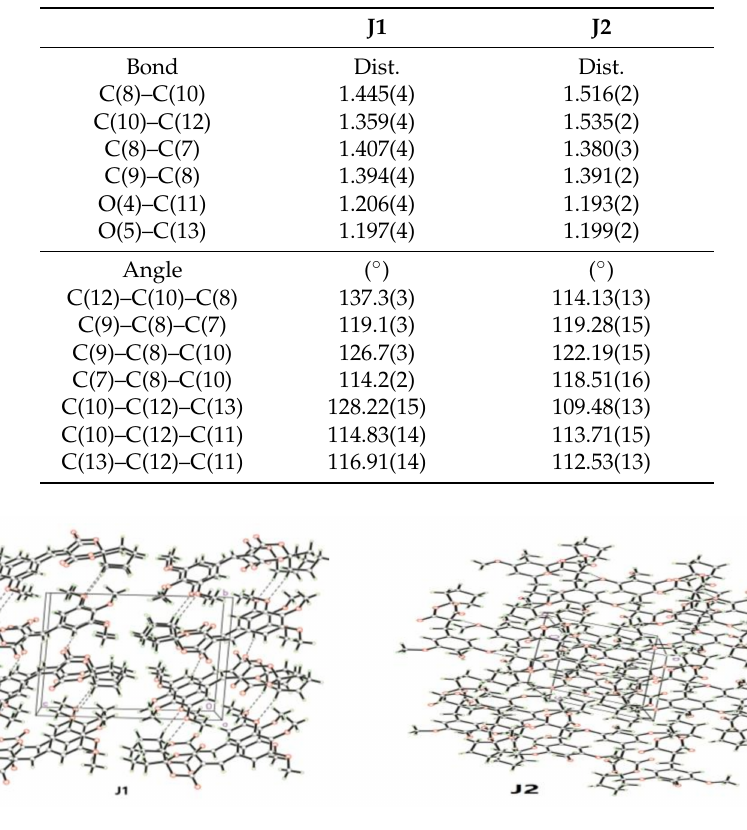
Figure 2. Perspective views of three-dimensional packing structures of J1 and J2